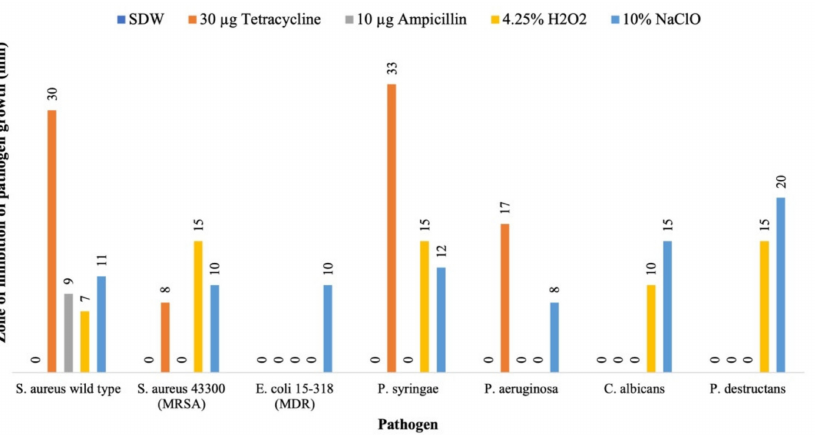
Figure 3. Susceptibilities of the seven microbial pathogens to two known antibiotics and two chemical agents used in this study.